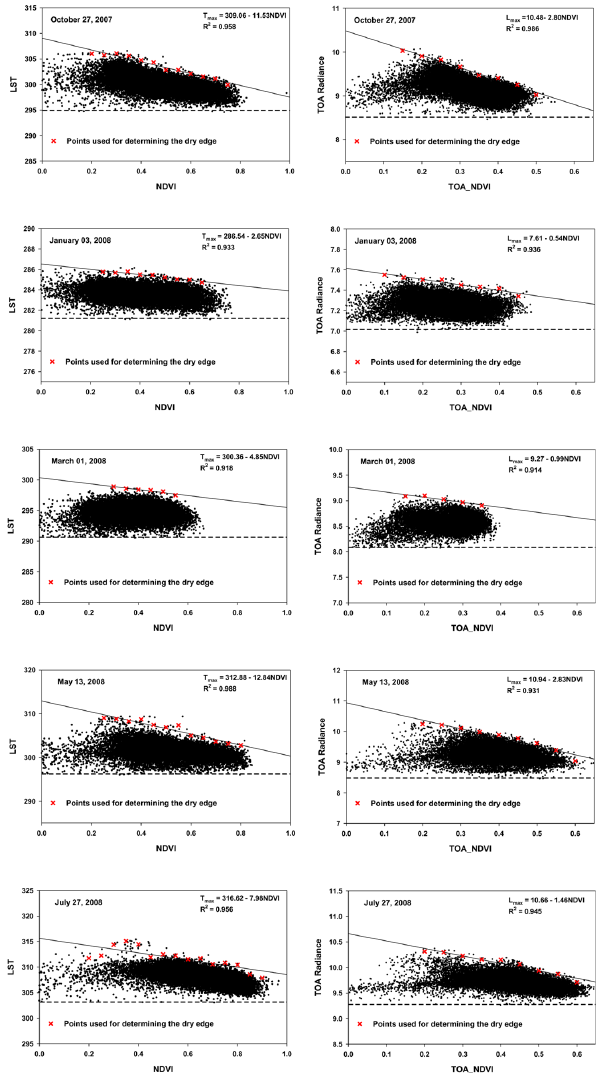
Fig. 4. Illustrative examples of LST/NDVI scatter plots constructed respectively from MODIS products and TOA radiances for five rep- resentative days over the study area during the study period.